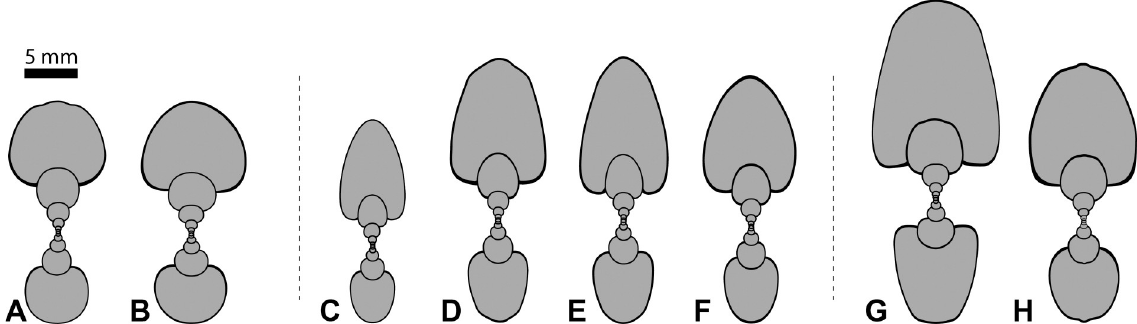
Fig 1. Cross sections of the analyzed ammonoid species of the late Anisian Fossil Hill Member of NW Nevada, USA; all × 1.5. (A) Frechites nevadanus , GSUB C12377. (B) Frechites nevadanus , GSUB C13250. (C) Gymnotoceras weitschati , GSUB C14190. (D) Gymnotoceras blakei , GSUB C12243. (E) Gymnotoceras mimetus , GSUB C13814. (F) Gymnotoceras rotelliformis , GSUB 11594. (G) Parafrechites dunni , GSUB C9356. (H) Parafrechites meeki , GSUB